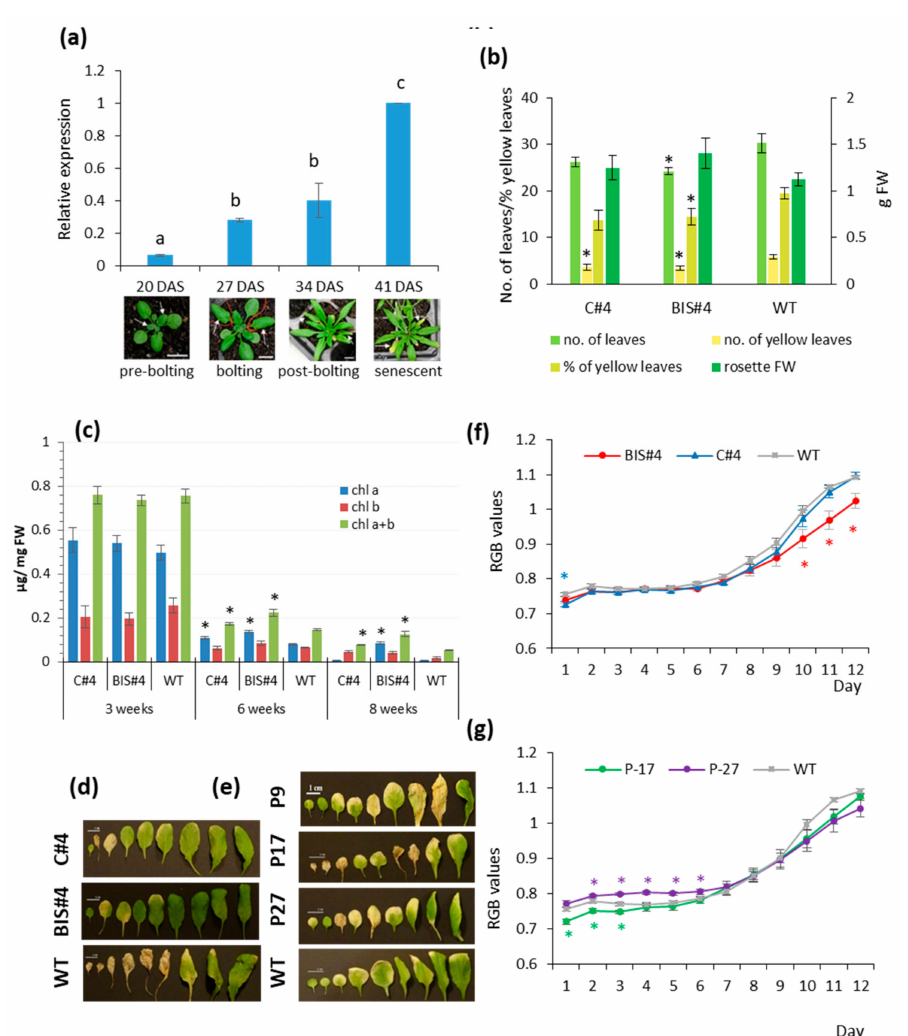
Figure 1. The expression of AtCuAO δ and the e ff ects of its perturbation on senescence: ( a ) gene expression in leaf 5 and 6 of rosettes during leaf development and senescence (n = 3, ± SE); ( b ) total number of leaves, number of yellow leaves, % of yellow leaves, and rosette fresh weight after 8 weeks growth of the two mutants C#4 and BIS#4 (n = 8, ± SE); ( c ) chlorophyll levels in leaves no. 5 and 6 of mutants C#4 and Bis#4 at three di ff erent stages ( ± SE, n = 6); ( d ) leaf yellowing of the nine oldest leaves (oldest to youngest, left to right) from 8-week-old rosettes (scale bar = 1 cm) of the two mutants C#4 and BIS#4; ( e ) over-expressor lines P9, P17, and P27; ( f ) yellowing as measured by changes in RGB (increased yellowing) during dark-induced senescence in C#4 and BIS#4; ( g ) over-expressor lines P17 and P27 (n = 9, ± SE). Significant di ff erences in means are indicated by * at p ≤ 0.05 based on a T -test; di ff erent lettering is based on a one-way ANOVA followed by a Tukey’s test; DAS is days after